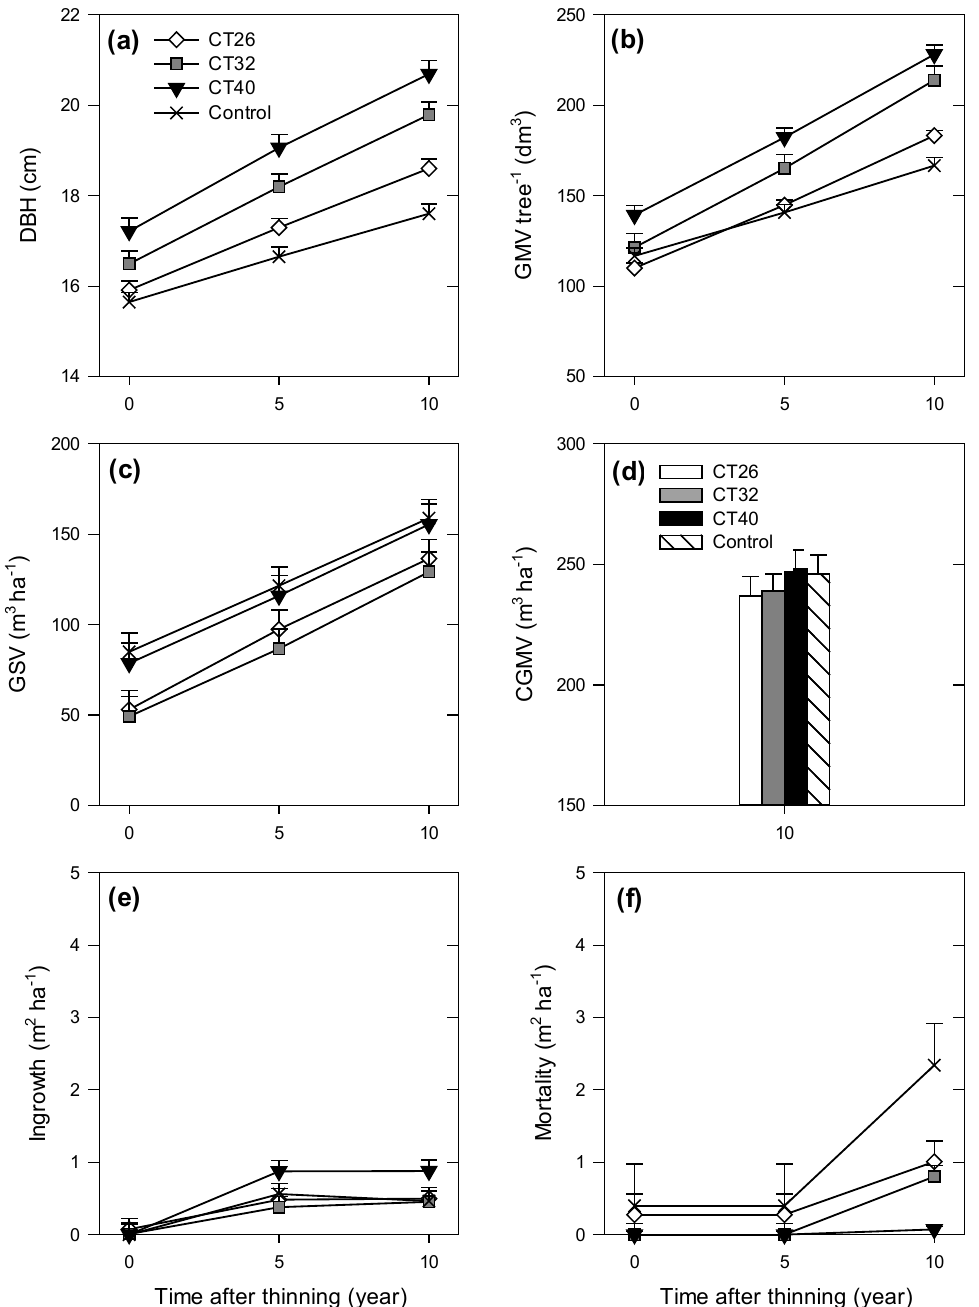
Figure 3. Mean tree- and stand-level development after four commercial thinning intensities from below (0%, 26%, 32%, 40% merchantable basal area removals). Dependent variables were: ( a ) mean diameter at breast height (DBH) of residual merchantable trees; ( b ) mean gross merchantable volume (GMV) of residual merchantable trees; ( c ) gross sawlog volume (GSV) per·ha –1 ; ( d ) cumulative gross merchantable volume (CGMV) per·ha –1 ; ( e ) ingrowth; and ( f ) mortality. Means (± SE) represent adjusted values from statistical analyses at the mean value of the covariate and are based on three replicates per